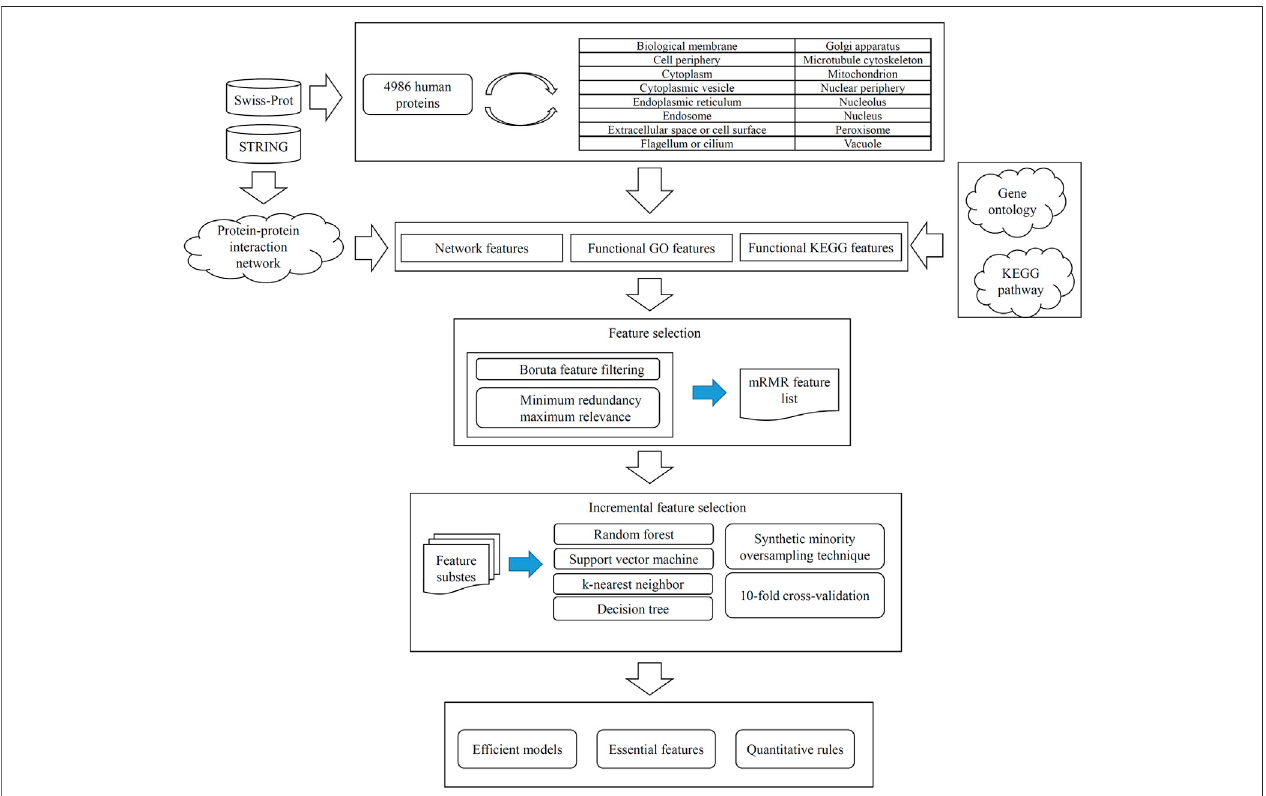
FIGURE 1 | Entire procedures for constructing and evaluating protein subcellular location prediction models. Human proteins and their subcellular location information are retrieved from Swiss-Prot.Each protein isrepresented by three feature groups: networkfeatures, functional KEGG features, and functional GOfeatures. All features are analyzed by Boruta and minimum redundancy maximum relevance one by one, resulting in an mRMR feature list. Such list is fed into the incremental feature selection method, incorporating four classi fi cation algorithms, synthetic minority oversampling technique and 10-fold cross-validation, to build ef fi cient models, extract essential features and access quantitative